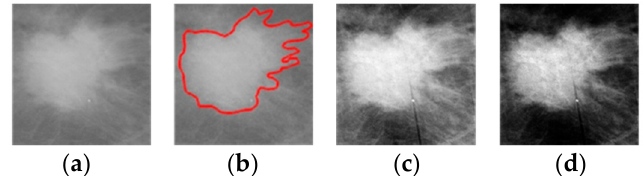
Figure 3. ( a ) Original ROI; ( b ) AD area marked by expert; ( c ) top–bottom hat transformation result; and ( d ) top–bottom hat transformation and Gamma transformation result.